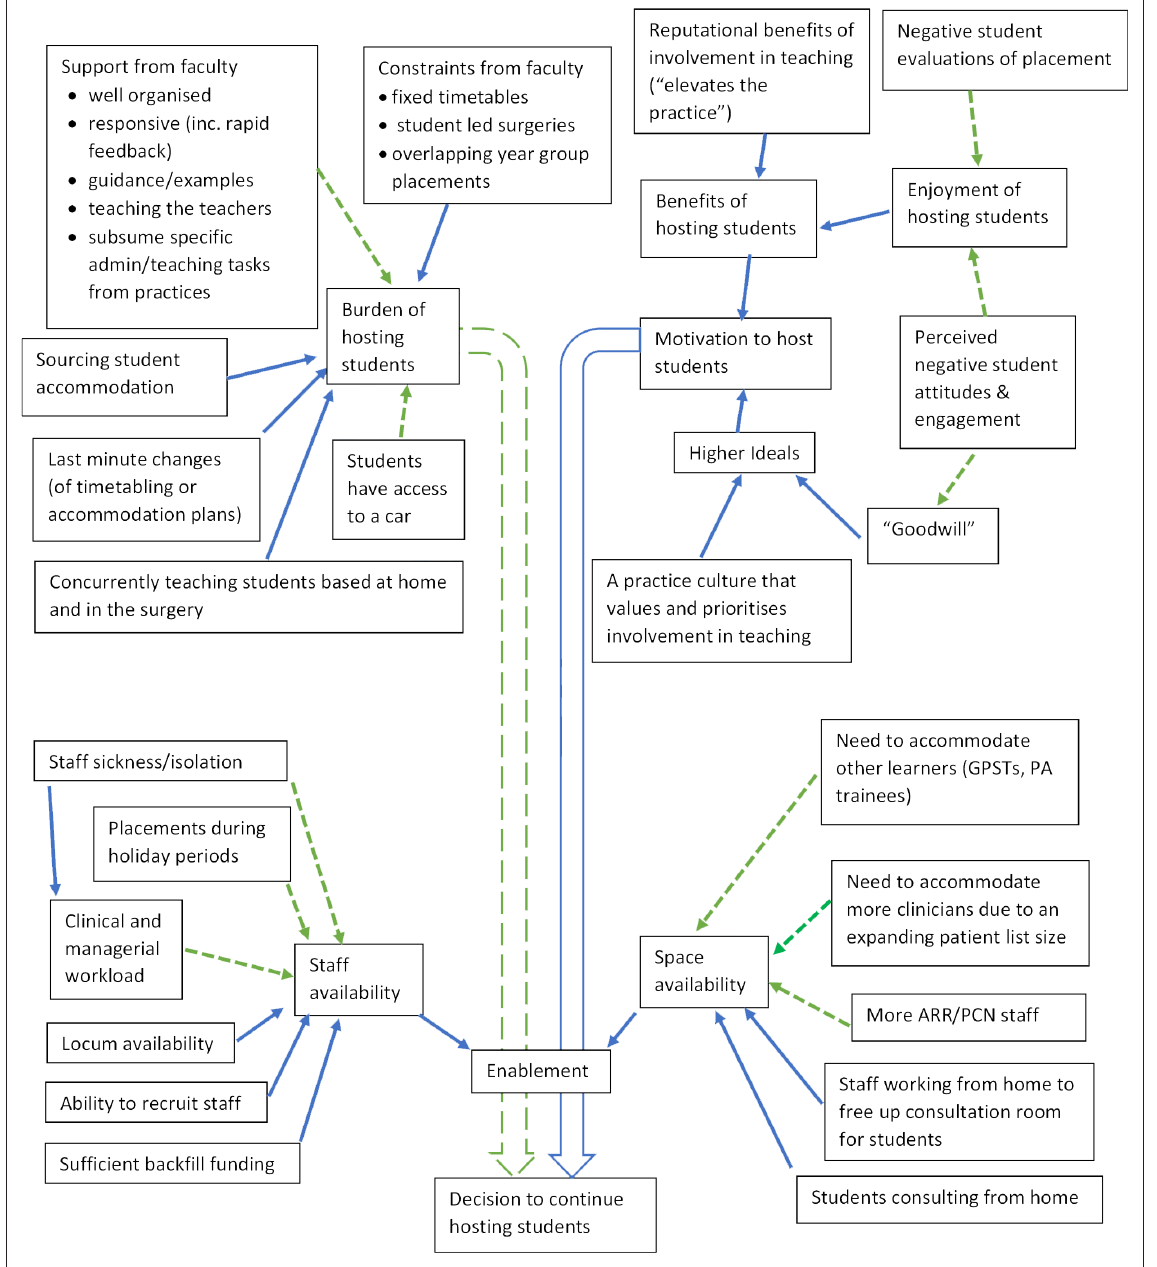
Figure 3 Thematic map of factors influencing a practice continuing to host medical student placements. (Solid blue line indicates an enhancing effect, dashed green line indicates a reductive